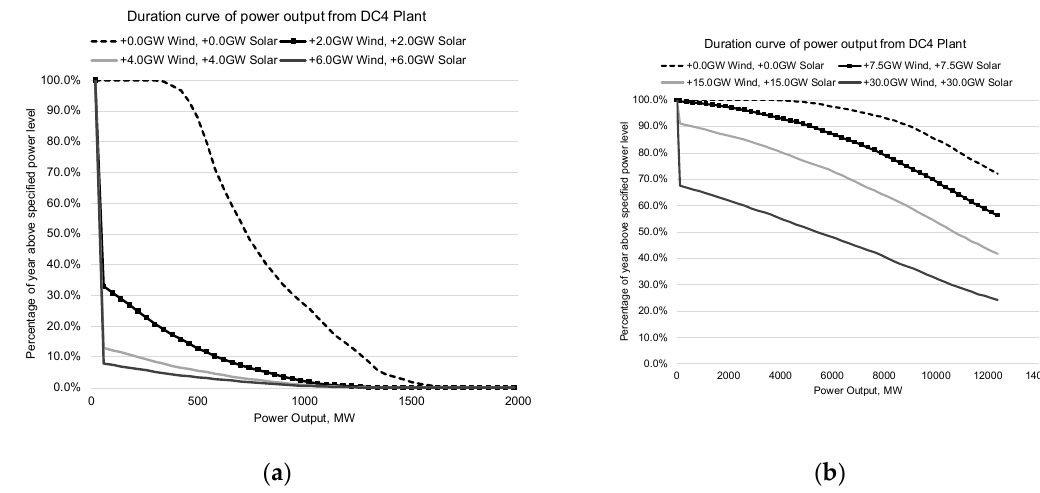
Figure 11. Histogram of dispatch times of DC4 assets different generation alternative scenarios in ( a ) New Zealand and ( b ) Great Britain.